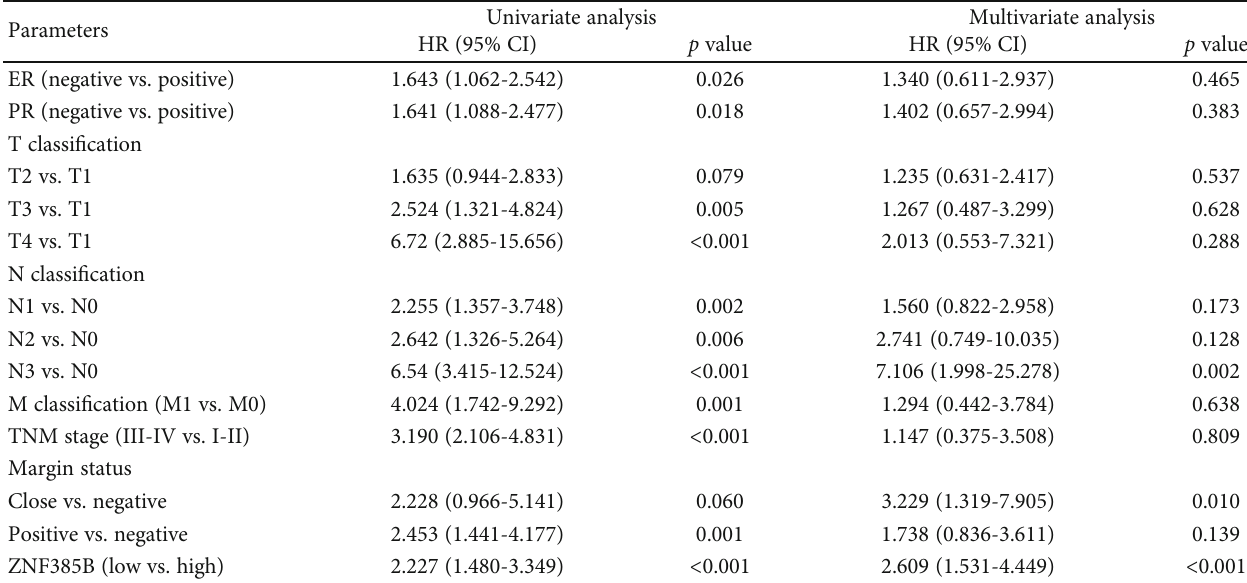
Table 4: Univariate and multivariate Cox regression analyses of various prognostic parameters of relapse-free survival in patients with breast